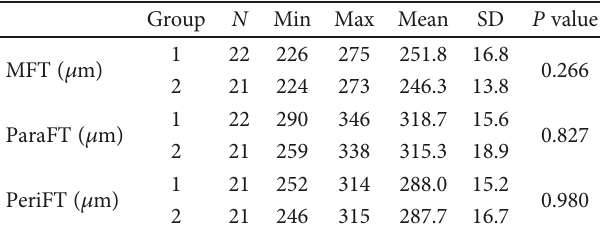
Table 2: Preoperative macular thickness measurements in groups 1 and